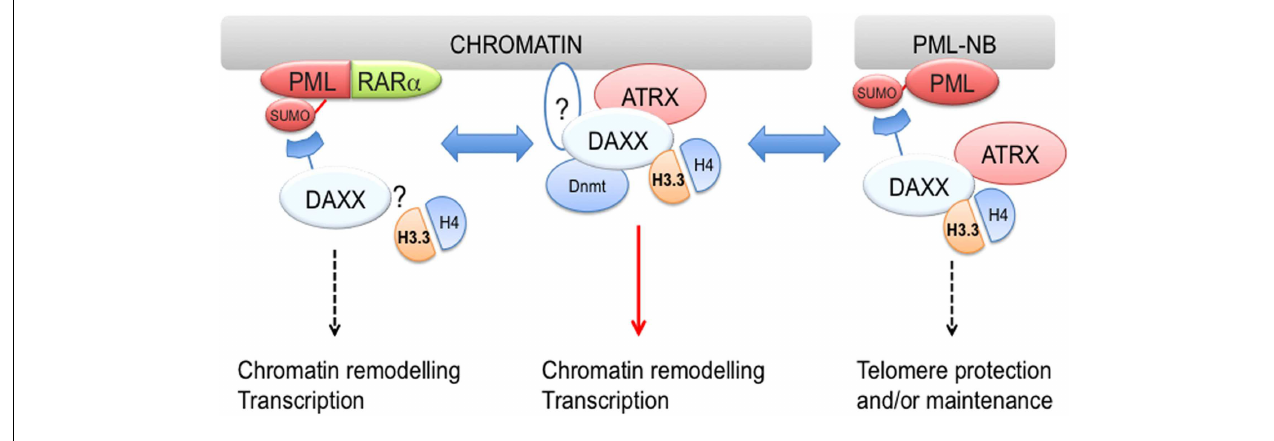
DAXX is recruited to PML-NBs via a SUMO-interacting motif (SIM)-dependent mechanism, it is still unclear whether a similar mechanism is implicated in its targeting to chromatin (see question mark in middle panel). DAXX also interacts with DNA methyltransferase 1 (Dnmt1) and targets its activity to chromatin, suggesting that DAXX coordinates multiple epigenetic